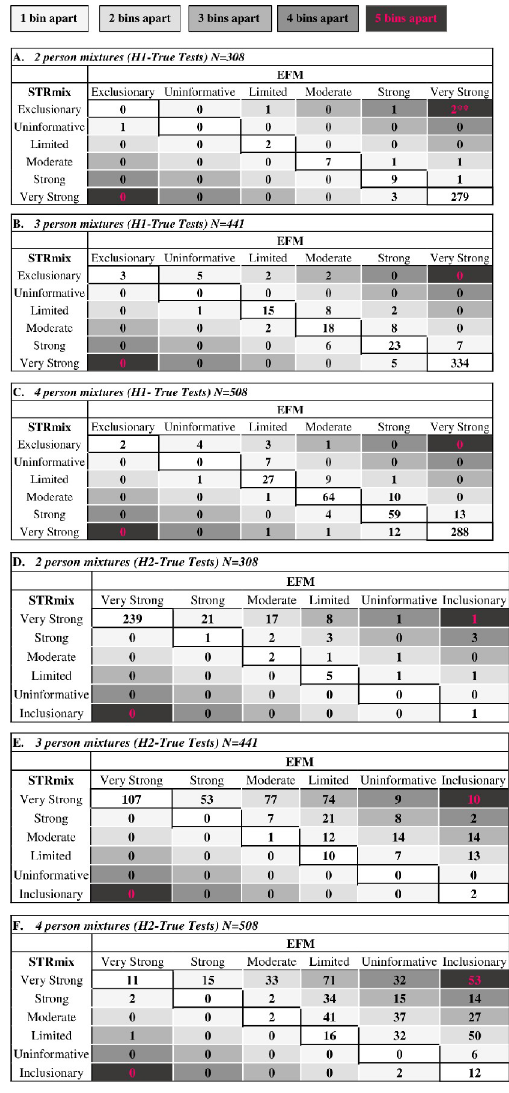
Fig 8. Concordance/discordance tables of the binned LR values assigned by STRmix and EFM into their verbal equivalents. The tables display the results of the categorization of the LRs for both the H1-true tests of (A) 2P where �� are the two 2P H1-true test interpretations for which STRmix assigned profile LRs of 0 (binned into the Exclusionary category and discussed in detail in Section 3.6), (B) 3P, and (C) 4P and H2-true tests of (D) 2P, (E) 3P, and (F) 4P generated in STRmix and EFM into their corresponding verbal expression. Also, the tables demonstrate the observed differences in the verbal expressions between the two LR systems. The number of cases that resulted in same verbal expression between STRmix and EFM fell inside the diagonal (white cells). All the numbers outside the diagonal (shaded cells) are indication of cases where LRs from both software were classified into different categories and resulted in shifting by one or more than one verbal category (indicated by different shades as shown by the legend). Values in and above the diagonal are the results of the verbal expression of LRs produced in EFM while values in and below the diagonals are the results of the verbal expression of LR values assigned by STRmix. The verbal expressions are shown at the top and left edges of the tables. LRs of the 4P mixtures (Tables D, E, and F in Fig 8). For the 60 2P cases that were different ver- bally, 35 were placed in non-neighboring categories (Table D in Fig 8). With 3P and 4P analy- sis, (242 cases out of 321) and (367 cases out of 467), respectively, were classified into non- adjacent categories (Tables E and F in Fig 8).